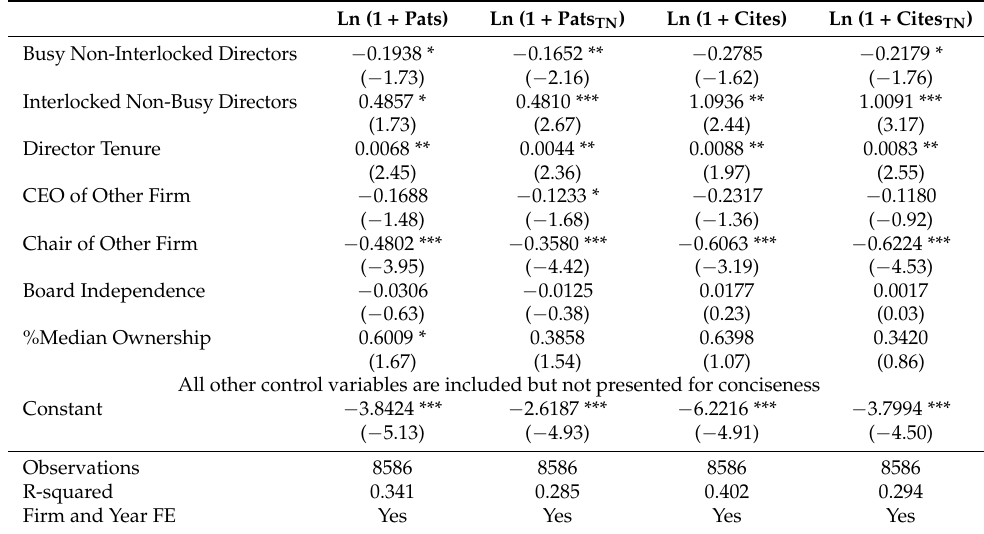
Table 10. Horse Race: Regressions of Innovation on All Corporate Governance Variables. This table presents regression results of Innovation on various measures of corporate governance variables examined in the previous tables, including Director Busyness, Director Interlocks, Director Entrench- ment, Director Experience, Board Structure and Director Ownership. Control variables are included in the analyses but not tabulated for conciseness. All regressions contain firm and year fixed effects. All except binary variables are winsorized at the upper and lower 1% levels. Full variable definitions are provided in the Appendix A. T-statistics are reported in parentheses. Standard errors are adjusted based on the Huber–White sandwich estimate of variances and are clustered by firm. *** indicates significance at the 1% level, ** 5% and *